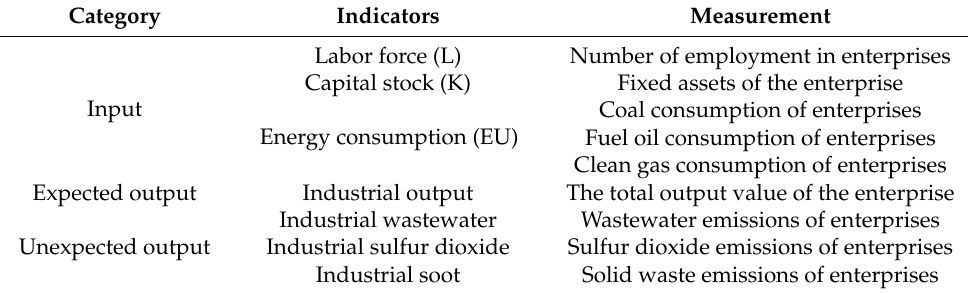
Table 2. Construction of indicators for the GTFEE measure of enterprises. Category Indicators Measurement Labor force (L) Number of employment in enterprises Capital stock (K) Fixed assets of the enterprise Input Coal consumption of enterprises Energy consumption (EU) Fuel oil consumption of enterprises Clean gas consumption of enterprises Expected output Industrial output The total output value of the enterprise Industrial wastewater Wastewater emissions of enterprises Unexpected output Industrial sulfur dioxide Sulfur dioxide emissions of enterprises Industrial soot Solid waste emissions of